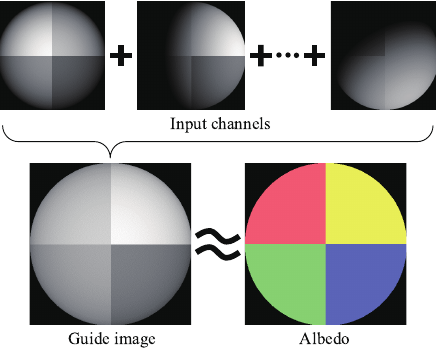
Figure 4. Average image calculated from seven channel images resembles the